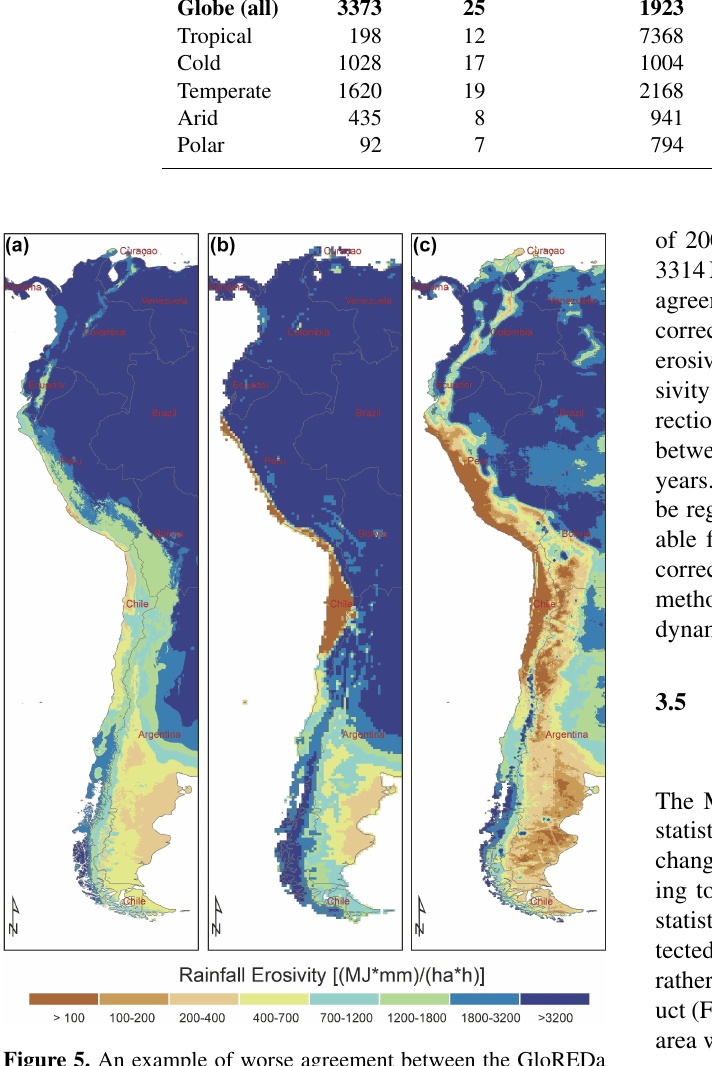
areas where the R factor is close to the global mean, the CMORPH underestimation is about 1.5, while better agree- ment can be seen in low-erosivity areas (arid, cold) (Fig. 9). Thus, applying this simple linear transformation can yield better agreement between GloREDa and CMORPH COR , both at a station scale (Fig. 9) as well as at a global scale (Fig. S2). The same correction was also applied to the global rainfall erosivity map derived using the CMORPH prod- uct (Fig. S2) and yielded a global mean rainfall